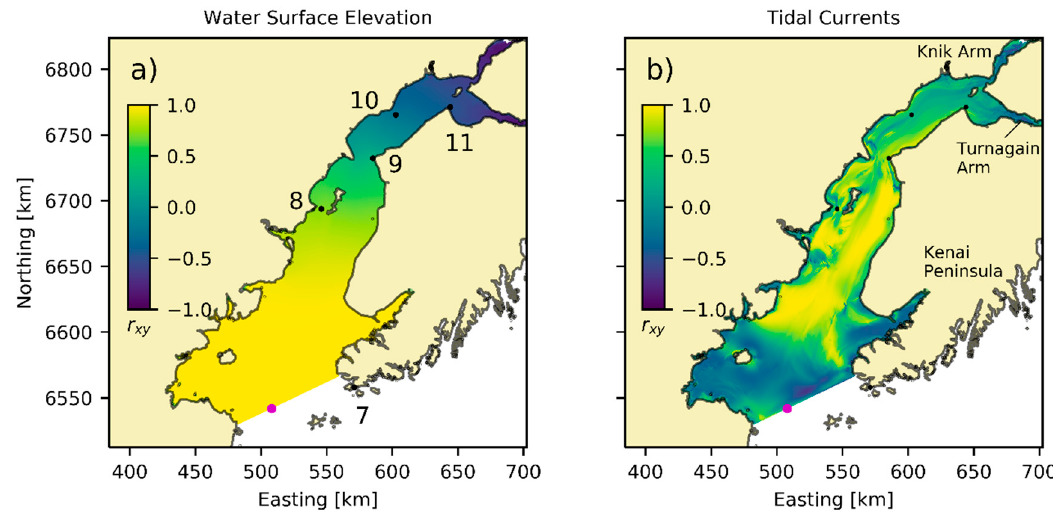
Figure 4. Cross-correlations for water surface elevation ( a ) and depth-averaged tidal currents ( b ) based on WY19 with respect to the open boundary point in magenta.